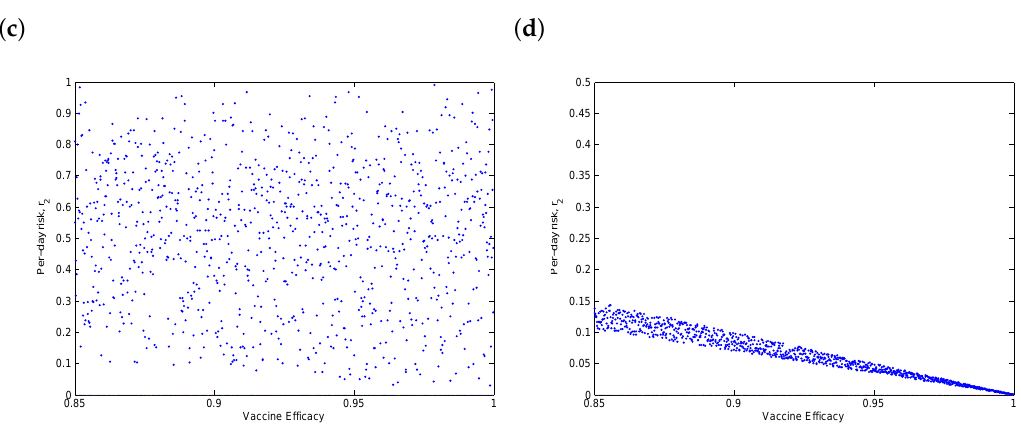
Figure 4. Sensitivity of the daily risk of COVID-19 to ( a ) vaccine uptake (0.25 ≤ q 7 ≤ 1), ( b ) the fraction of people using no protection, ( c ) vaccine efficacy and ( d ) the ideal scenario of perfect vaccine uptake ( q 7 = 1). Note the reduced scale on the y -axis in the last figure. The transmission rate β is between 0.7 and 1.